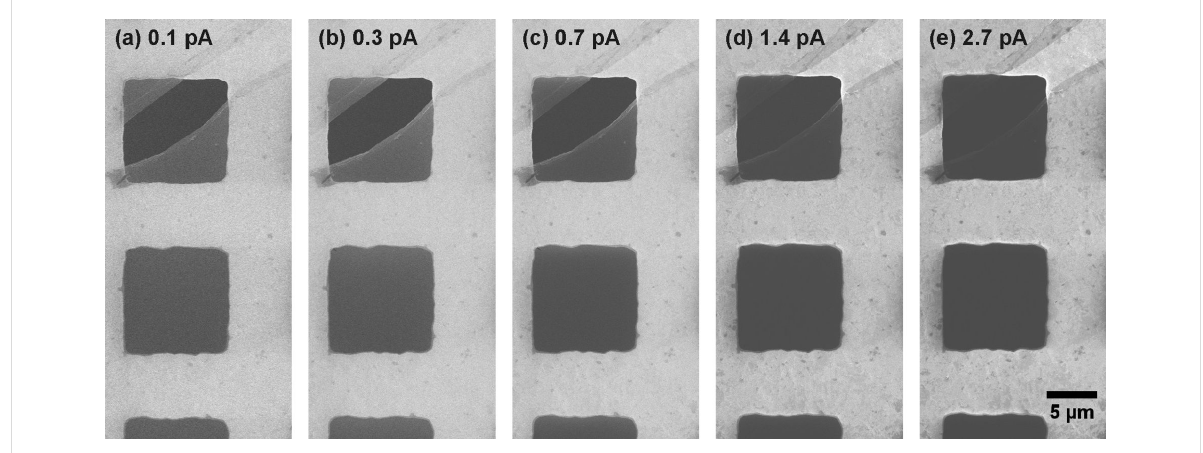
Figure 5: CNM on a gold grid. The same spot was imaged with different beam currents but under otherwise identical conditions. All images were taken without charge compensation. For a reasonable comparison of these images, the greyscale levels of the dark background of the uncovered openings as well as the surface of the bare gold areas were adjusted to be identical by means of changing the brightness and contrast of each whole image. Detailed information on all HIM images is given in Supporting Information File 1, Tables S1 and S2.